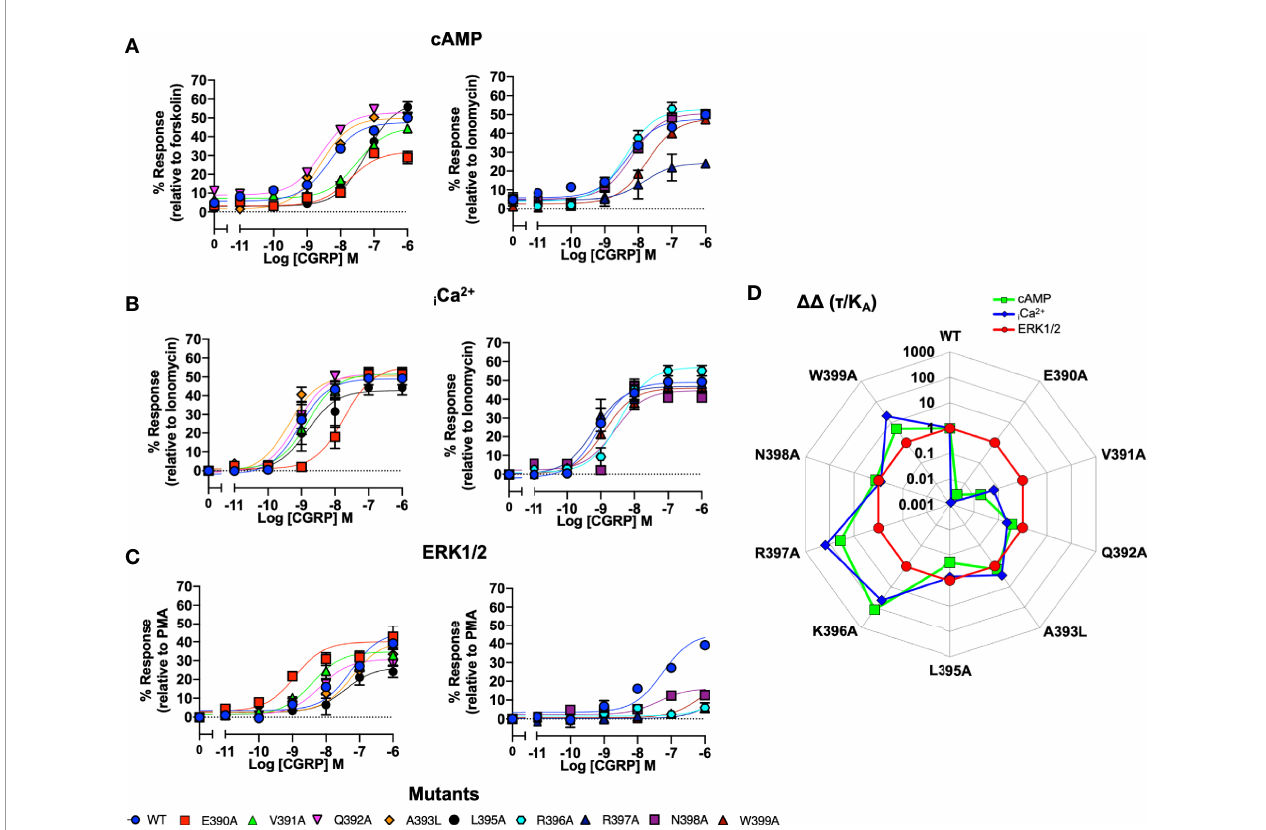
FIGURE 4 | Signaling bias of alanine mutants of H8 at the CGRP receptor. Residues in the H8 were mutated to Ala and the effects on (A) cAMP production, (B) elevation of 2+ , (C) ERK were compared to wild type receptor, (D) Signaling bias plot was calculated as 10 DD ( t /KA) for each mutant and each signaling pathway relative to WT and i Ca ERK1/2 phosphorylation. All data are mean ± SEM of n repeats where n=minimum of 3